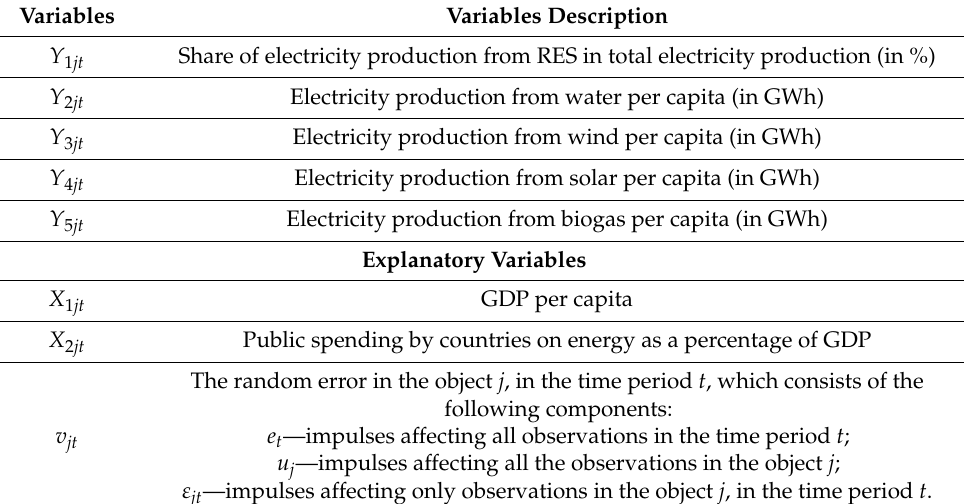
Table 4. The description of